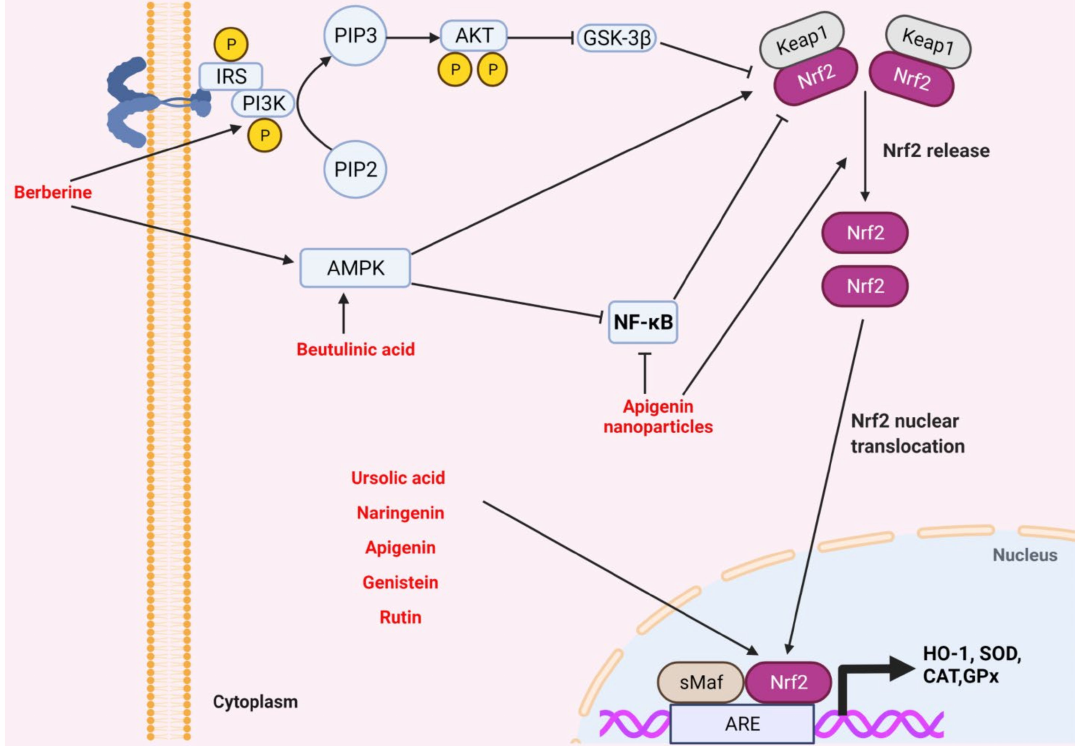
Figure 4. Medicinal plants and bioactive compounds that activate the Kelch-like ECH-associated protein 1/nuclear factor erythroid 2-related factor 2/antioxidant response element (Keap1/Nrf2/ARE pathway). Activation of the insulin receptor recruits PI3K that converts phosphatidylinositol 4,5- bisphosphate (PIP2) to phosphatidylinositol 3,4,5-triphosphate (PIP3). PIP3 activates Akt, which in turn inhibits glycogen synthase kinase 3 β (GSK-3 β ), relieving its inhibitory action on cytosolic Nrf2. Activation of AMPK releases cytosolic Nrf2 from Keap1 in a direct and an indirect manner. The nuclear translocation of cytosolic Nrf2 leads to activation of the antioxidant response element and transcription of antioxidant enzymes such as heme oxygenase-1 (HO-1), super oxide dismutase (SOD), catalase (CAT), and glutathione peroxidase (GPx). Berberine directly activates PIP3, leading to AKT-mediated activation of cytosolic Nrf2 through inhibition of GSK-3 β . In addition, berberine and betulinic acid activate AMPK, leading to the release of cytosolic Nrf2. Apigenin nanoparticles inhibit NF- κ B, thus allowing for the release of Nrf2. Ursolic acid, naringenin, apigenin, genistein, and rutin increase the nuclear level of Nrf2 and its transcriptional activity, leading to an increase in the expression of antioxidant